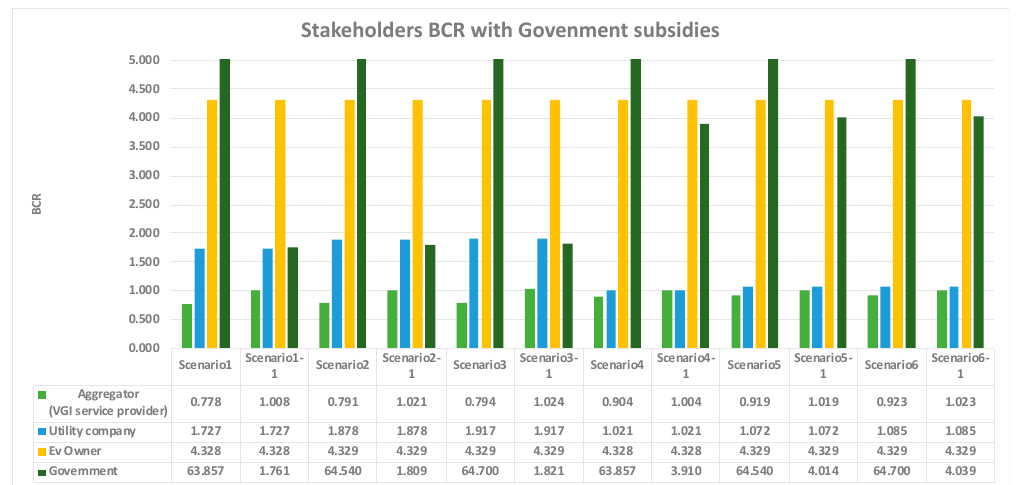
Figure 6. Stakeholders’ BCR with government subsidies.